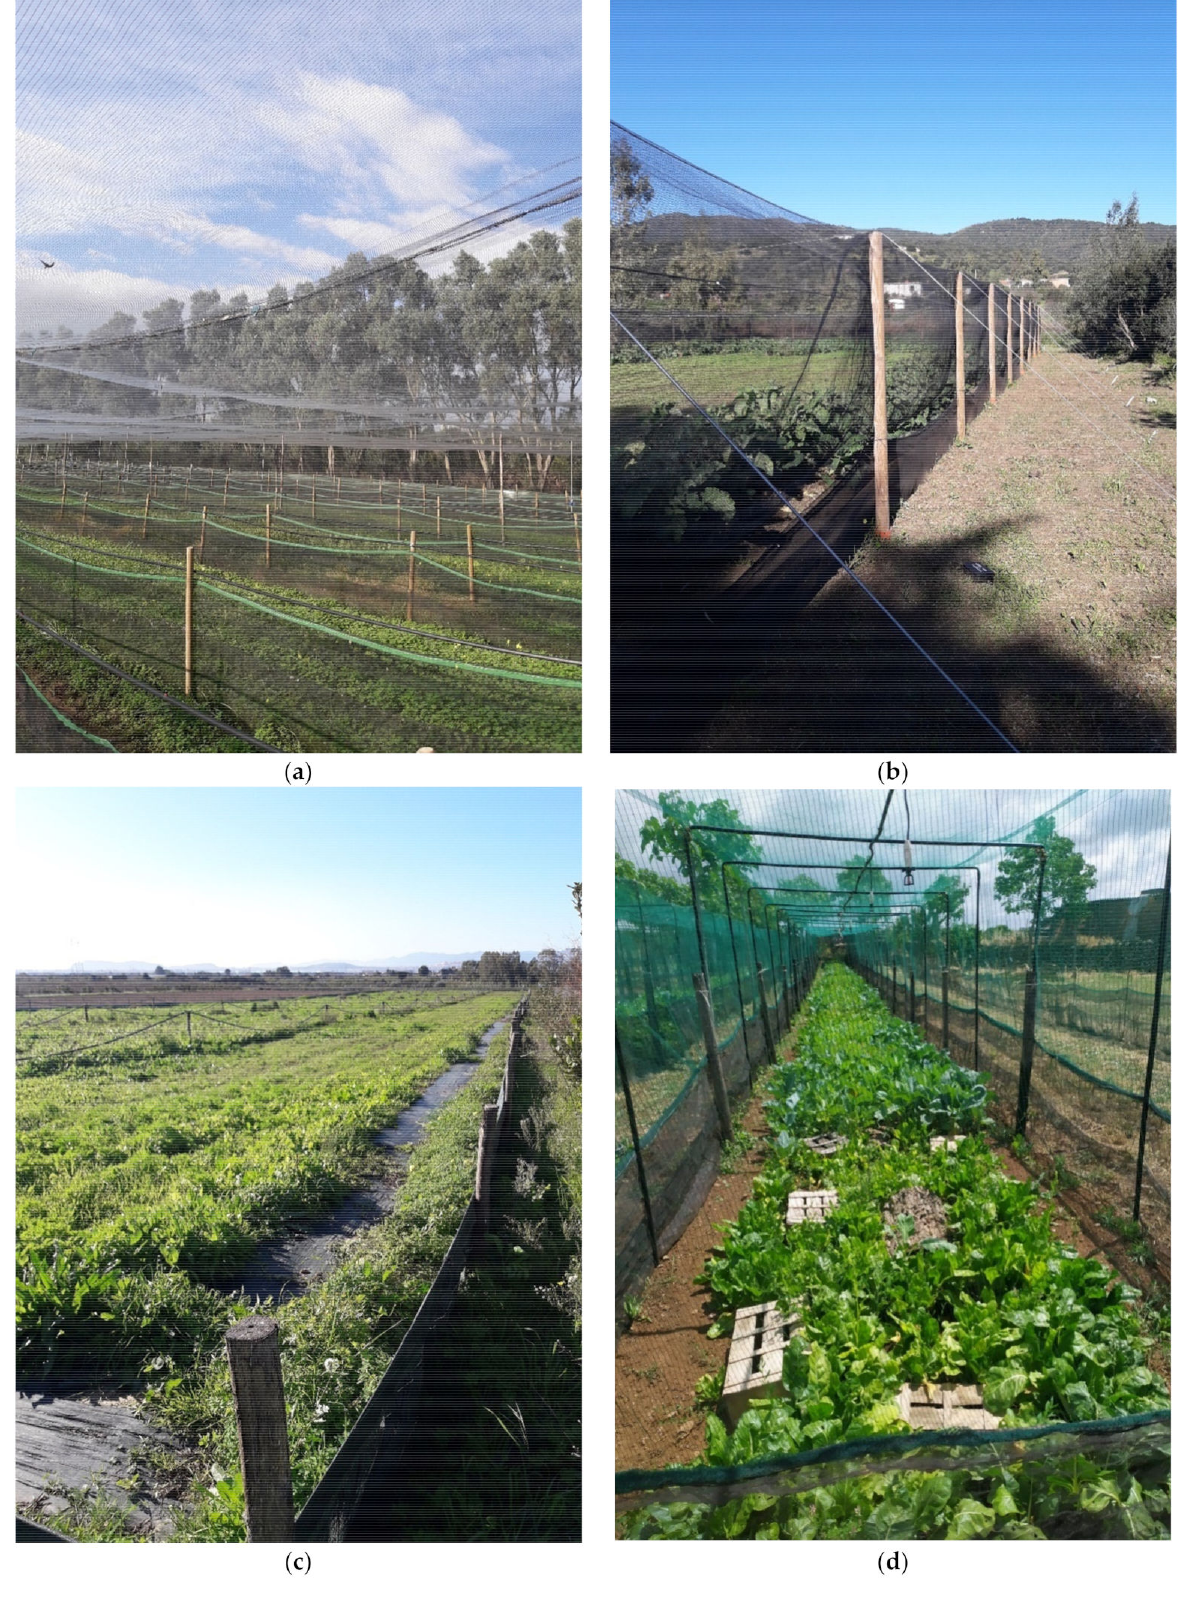
Figure 2. Types of fences and rows in the seven farms involved in this study: ( a ) single-fenced row with unique superior net, ( b ) simple perimeter fence, ( c ) unique rows with perimeter metal fence without net, and ( d ) single-fenced row with single superior